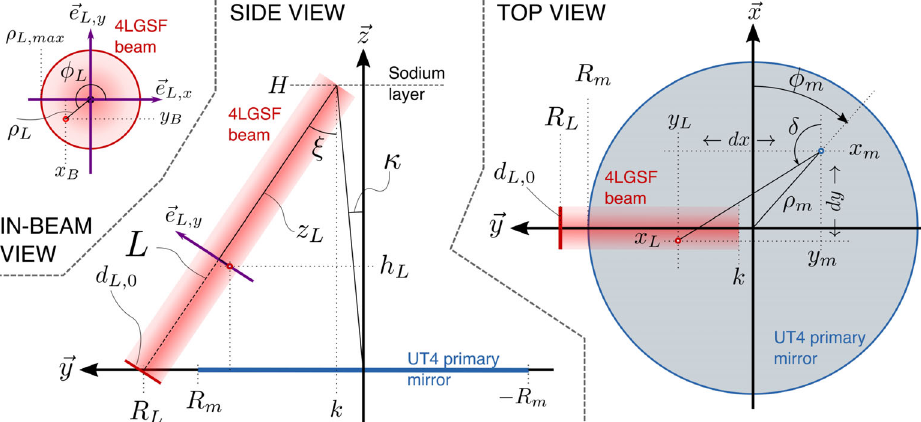
FIG. 9. Simple model of the 4LGSF (one laser only) and UT4 (reduced to a flat primary mirror). The laser is set to propagate from a distance R L from the optical axis of the telescope along the ⃗ y axis. The beam is 30 cm in diameter and assumed to maintain a constant width as a function of